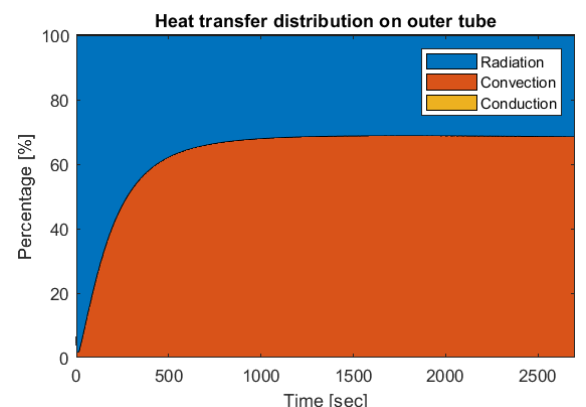
Fig. 20. Percentage of heat transfer on outer tube .